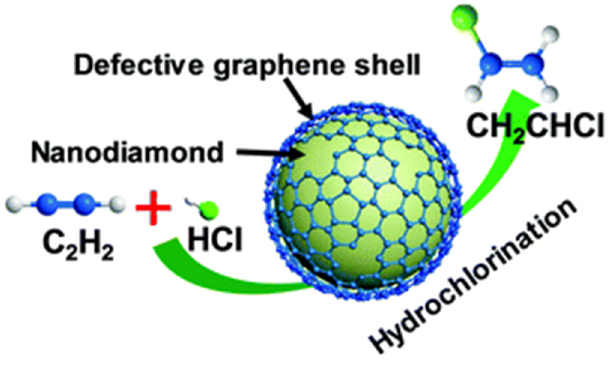
Figure 19. Defective nanodiamond–graphene catalyst for acetylene hydrochlorination